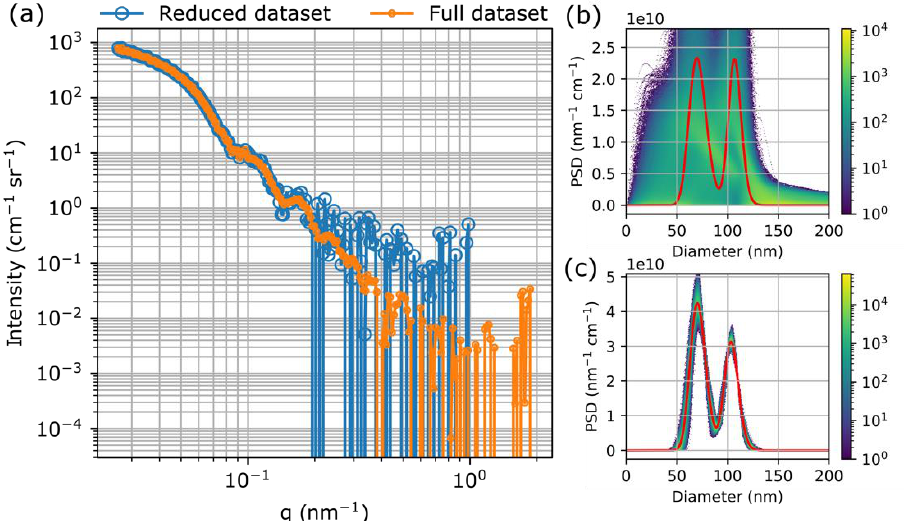
Figure 3. ( a ) Scattering curves of the SNP022 sample measured at a reduced and an extended (full) q-range and ( b , c ) the corresponding particle size distributions (PSDs) together with the heat map of possible PSDs calculated by taking the uncertainty and covariance of fitted parameters into account.